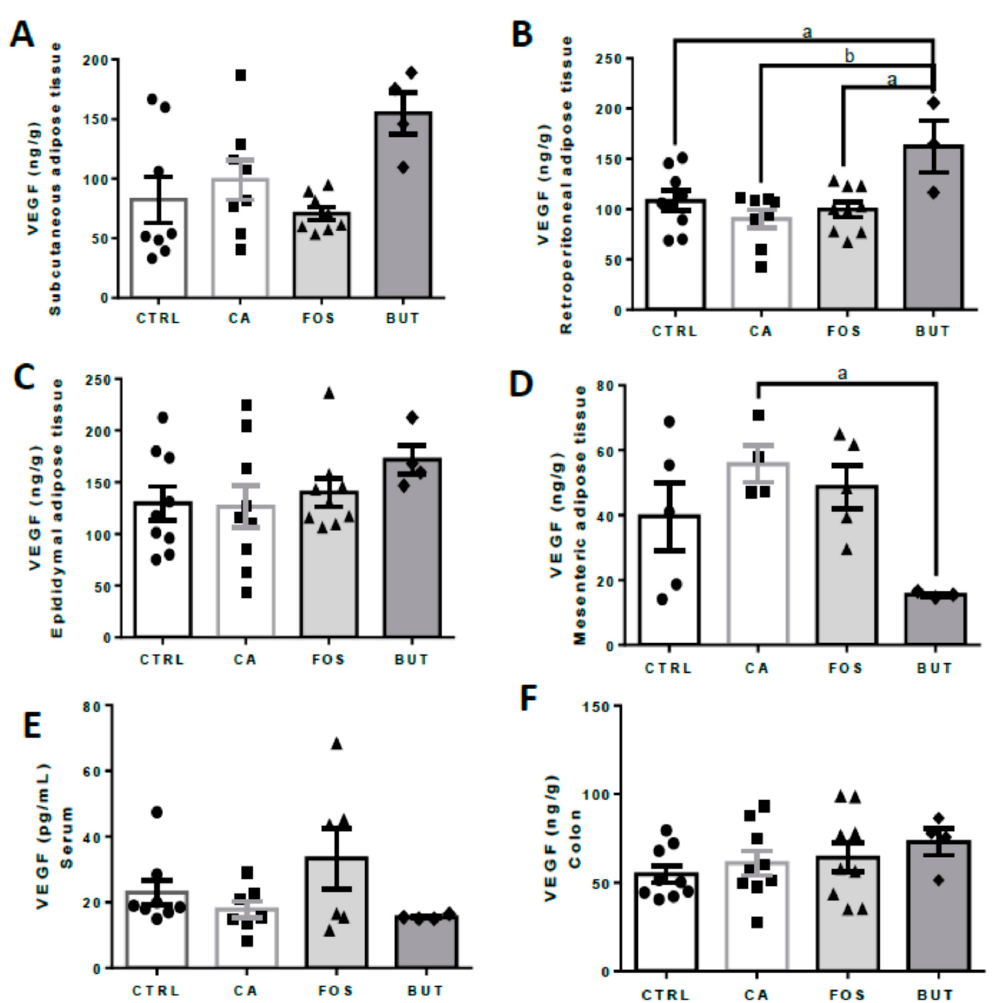
Figure 11. Butyrate promoted elevation of VEGF in retroperitoneal adipose tissue: VEGF concentrations in subcutaneous ( A ), retroperitoneal ( B ), epididymal ( C ), and mesenteric ( D )